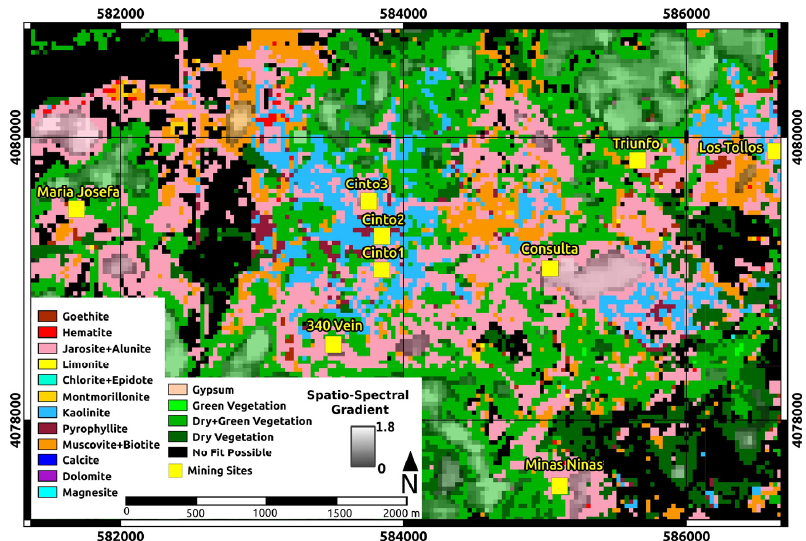
Figure 11. EnGeoMAP 2.0 best fit material map, using sensor dependent absorption depth thresholding, with a semi-transparent overlay of the spatio-spectral gradient using the entries of the USGS digital spectral library [12] as reference spectra.